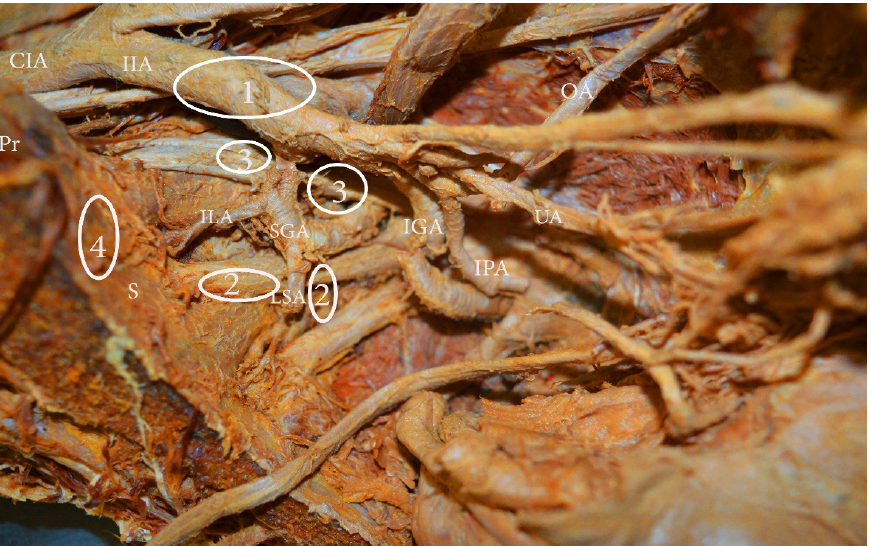
Figure 3. Internal iliac lymph nodes classification (embalmed cadaver—left hemipelvis). 1. Anterior—anterior to anterior division of internal iliac artery, 2. lateral sacral—close to the paired lateral sacral arteries, 3. gluteal—between superior gluteal and internal iliac artery, 4. sacral (presacral)— along median sacral artery. CIA—common iliac artery, IIA—internal iliac artery, OA—obturator